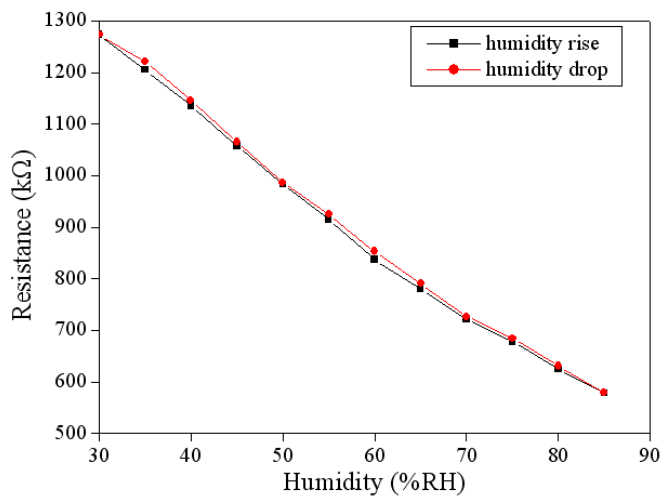
Figure 7. Measured results of the humidity sensor at 25